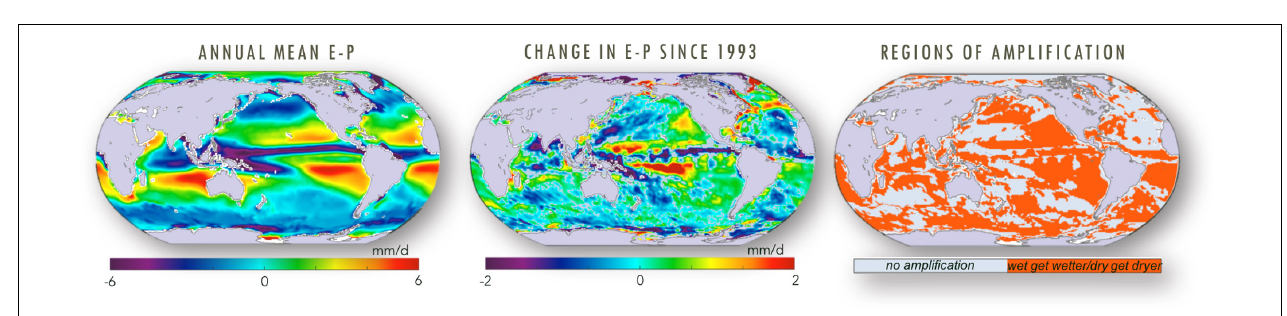
FIGURE 4 | Surface SSS trends as indicator of internal climate variability. Tropical changes in SSS over the past 20 years are partly attributed to Interdecadal Pacific Oscillation (IPO), explaining strong surface salinification in the Pacific warm Pool (red) despite an increase of flux of freshwater into the ocean (blue in Figure 5 ). Based on multi-platform salinity estimate ECCO that combines satellite and in situ data with dynamical constraints. Shown here are (A) Expression of the IPO loading pattern in surface salinity, computed by linearly regressing monthly ECCO salinity anomalies upon (B) the IPO time series in normalized units of standard deviation. (C) Trends in the IPO loading salinity patterns. (D) Residual trends after the relevant IPO loading pattern is removed. Trends in panels (C,D) represent the total change over 20 years, computed as a linear trend multiplied by the period length. Adapted from Vinogradova and Ponte (2017). Figure © Copyright July 2017 AMS.